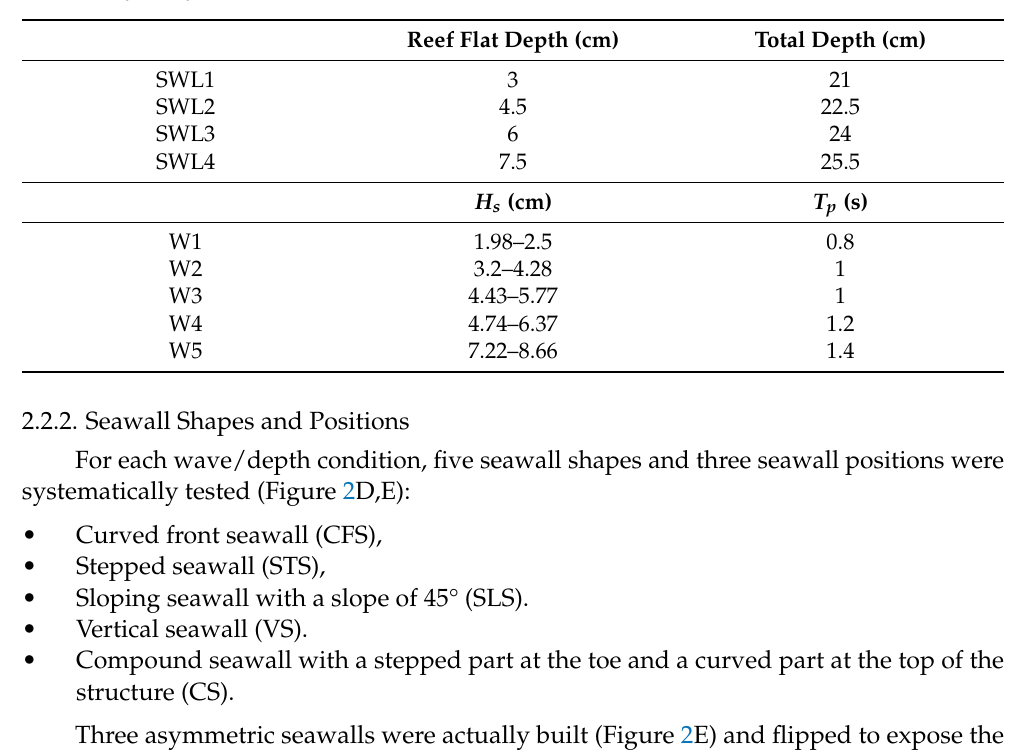
Table 1. Hydrodynamic conditions for the test